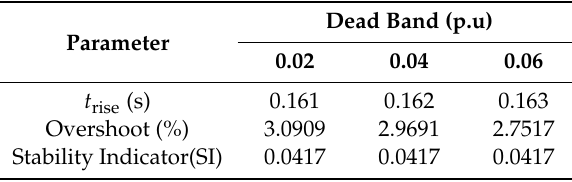
Table 3. Performance indicators result according to dead band range.